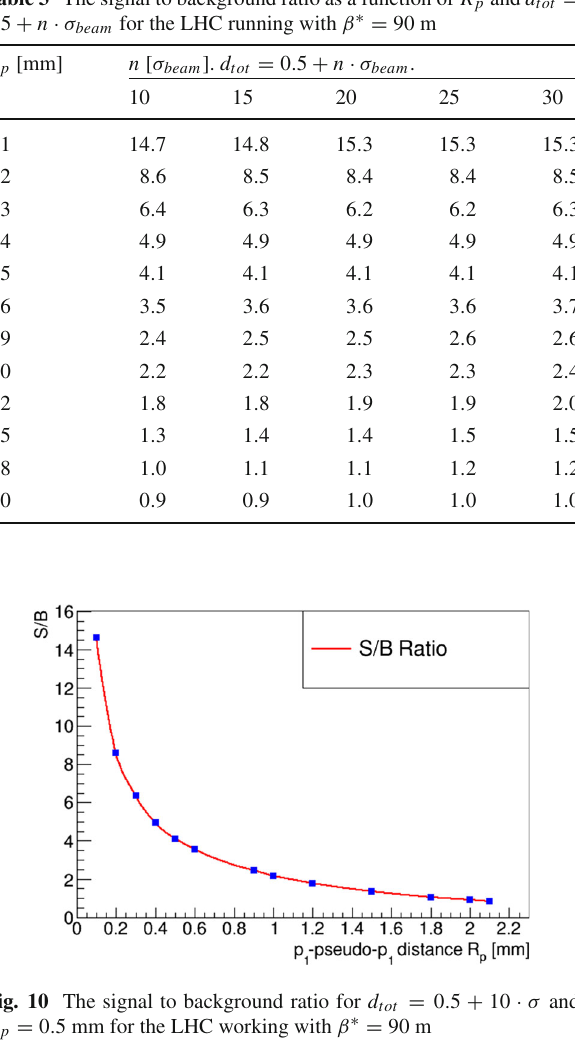
with R p increasing from 0.1 to 2.0 mm. This is illustrated in Fig. 10 which shows the signal to background ratio calculated for d tot = 0 . 5 + 10 · σ beam as a function of R p . It is worth noting that the signal visible cross-section ranges between about 3 and 30% of the diffractive bremsstrahlung cross- section within the discussed span of R p . Table 4 lists the signal and background visible cross- sections as a function of the detector–beam distance for the signal and background samples for R p = 0 . 5 mm. Also, the signal to background ratio is given in the table and the visible cross-sections are depicted in Fig. 11. As can be seen from Fig. 11 the visible cross-sections decrease by about 1/3 with increasing detector-beam distance (confront also Table 2). However, their dependence on d tot is very similar resulting, in fact, a practically constant the signal to background